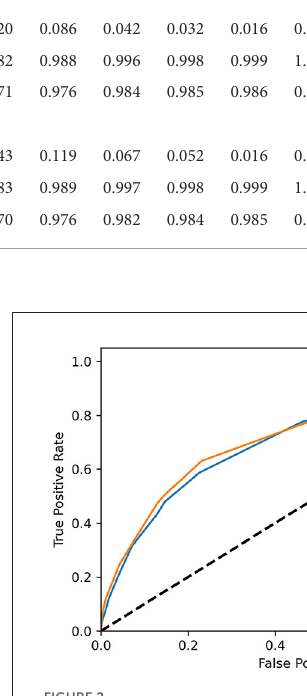
FIGURE2 The receiver operating characteristic curve demonstrated the performance of the scoring system for predicting NA in the training group (blue) and test group